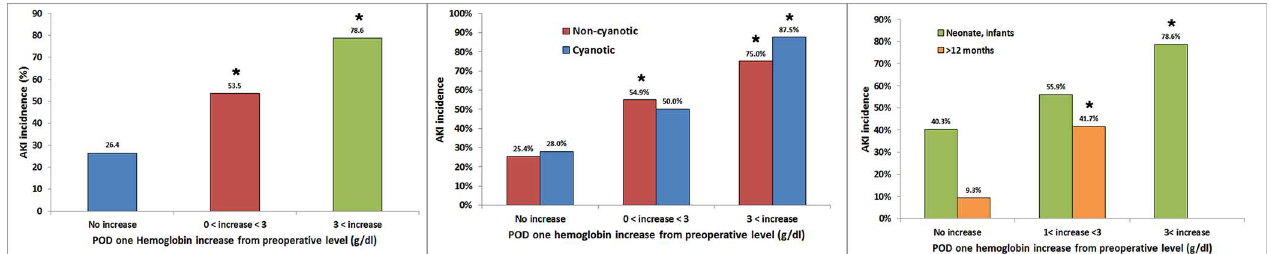
Fig 2. Incidences of postoperative acute kidney injury. The incidences were shown accordingto categorized hemoglobinincreaseon postoperative day one from preoperative level (g/dl) in all patients (left), in patients with non-cyanotic and cyanotic heart disease(middle), and in patient subgroup of neonatesor infants and children > 12 months